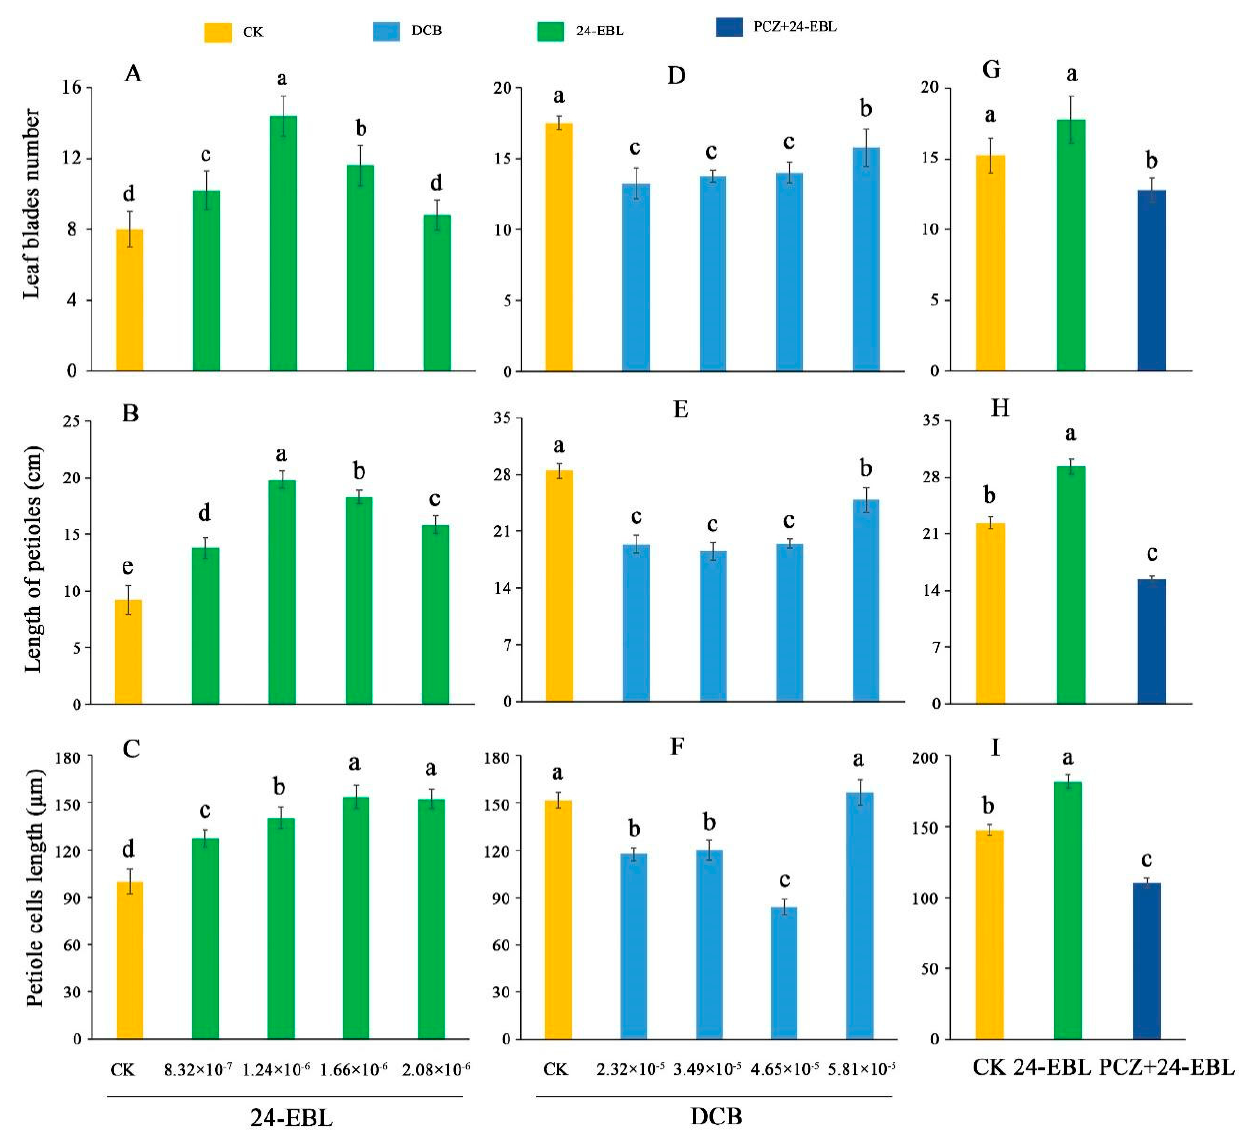
Figure 4. Effects of 24-EBL/PCZ/DCB treatments on leaf blade number, petiole length and petiole cell length in celery. ( A – C ) 24-EBL treatment groups; ( D – F ) DCB treatment groups; ( G – I ) PCZ + 24-EBL treatment groups. Column diagrams with different colors represent the data from celery plants in CK, 24-EBL, DCB and PCZ + 24-EBL treatment groups. Data are expressed as the means ± standard deviation (SD) of three replicates. Different letters indicate significant difference at 0.05 level.